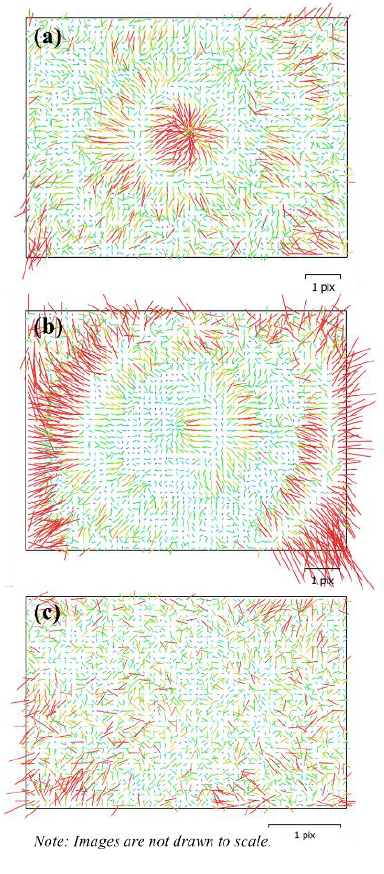
Figure 8 . Image residuals of (a) XT1092, (b) S20 and (c) D3200 after bundle adjustment.